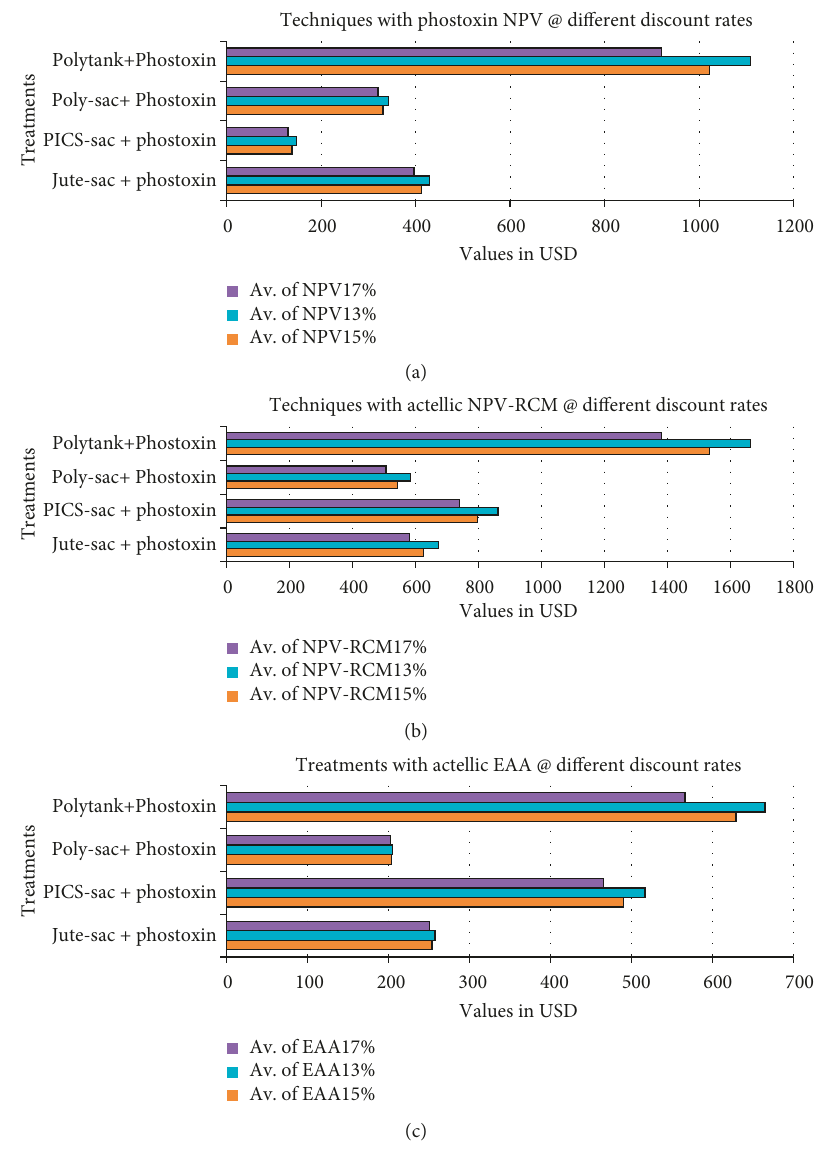
Figure 6: Performance of storage techniques treated with Phostoxin in maize